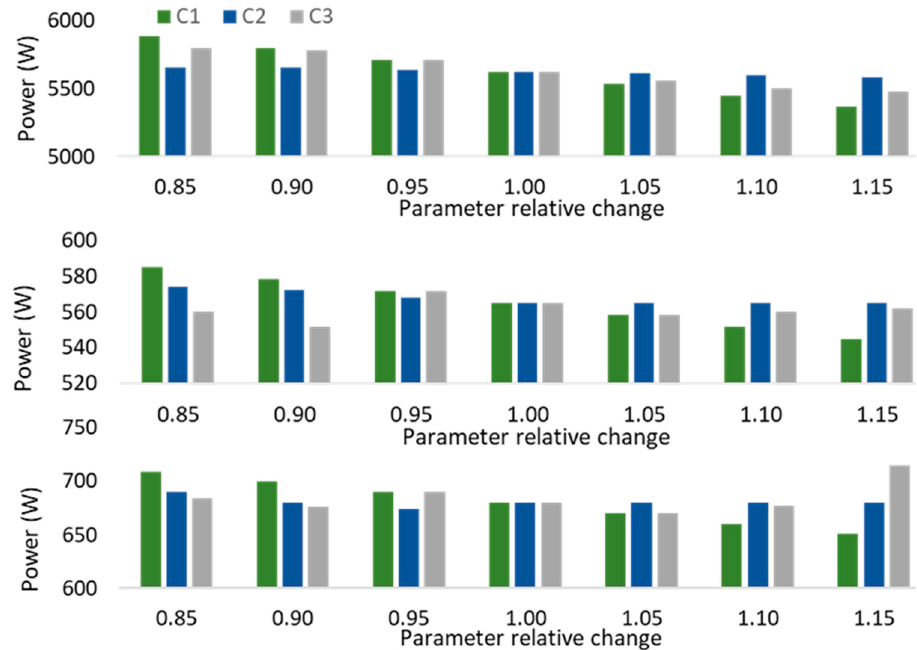
Figure 17. Consumption of devices in Room #5 regarding sensitivity analysis of constraint bounds.